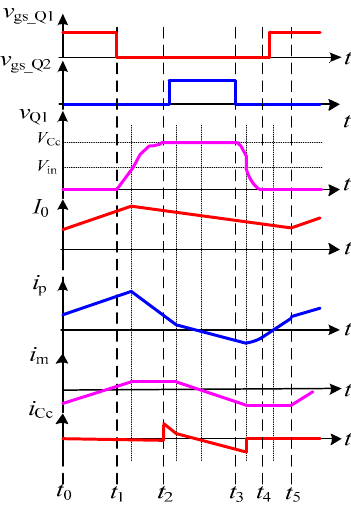
Figure 5. Key operating waveforms during one switching period.